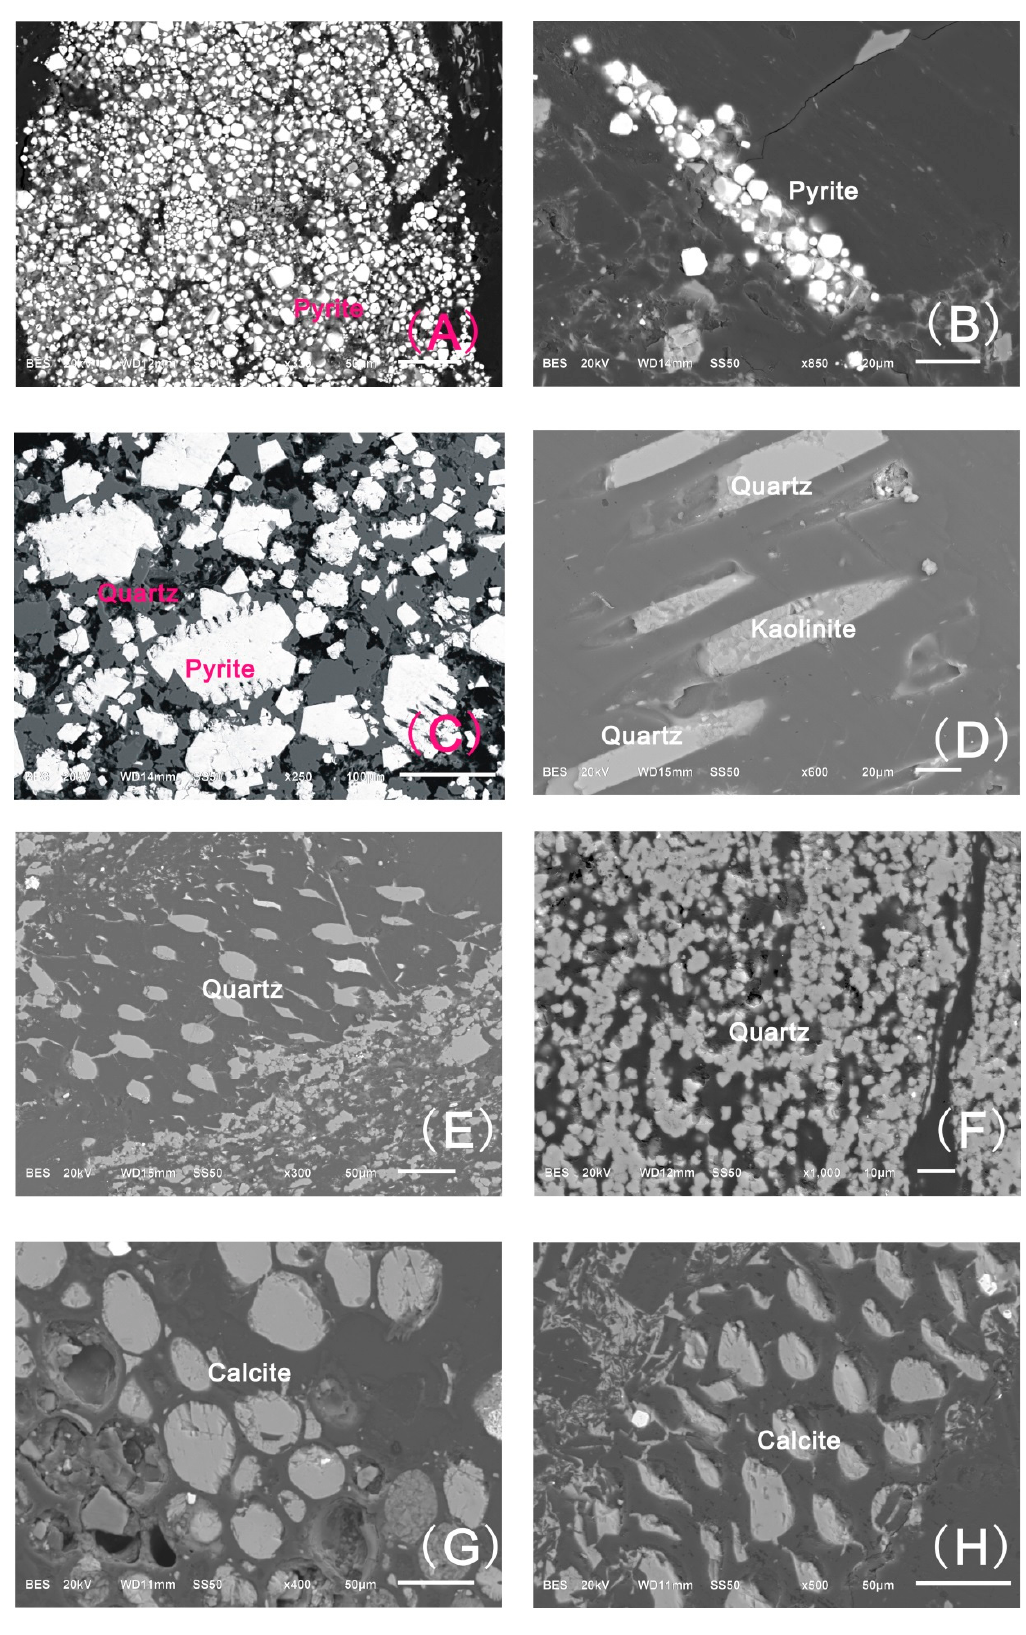
Figure 4. SEM back scattering images of minerals in the Zhongliangshan coals. ( A ) euhedral pyrite in sample K1-1; ( B ) euhedral pyrite in sample K10-4; ( C ) pyrite in sample K7-1; ( D ) cell-filling quartz and kaolinite in sample K1-2; ( E ) cell-filling quartz in sample K5-1; ( F ) quartz in sample K4-2; ( G ) cell-filling calcite in sample K4-2; ( H ) cell-filling calcite sample K4-2.